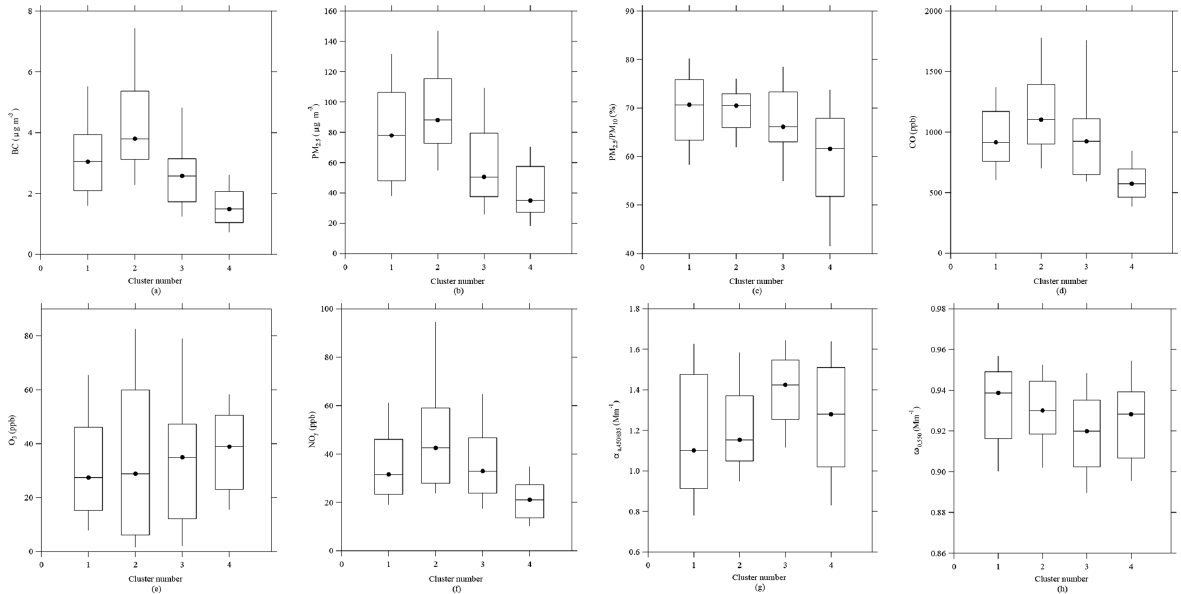
Figure 14. The 10th, 25th, 50th, 75th, and 90th percentile values in each cluster of back trajectories in the winter of 2016 of (a) BC, (b) PM 2 . 5 , (c) PM 2 . 5 / PM 10 , (d) CO, (e) O 3 , (f) NO y , (g) α ts , and (h) ω 0 . Black markers represent the